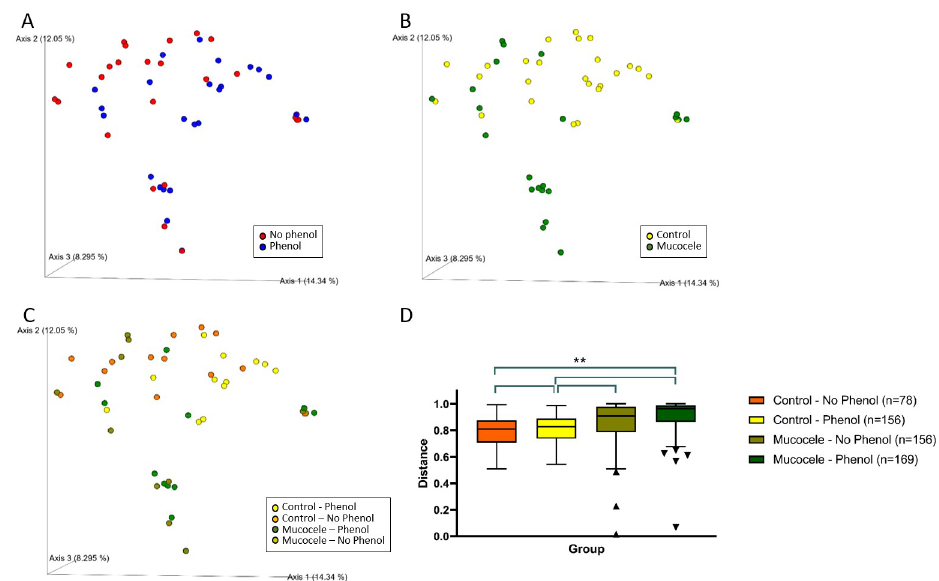
Fig 6. Beta diversity of amplicon sequence variants in gallbladder bile from 13 healthy dogs and gallbladder mucus from 13 dogs with mucocele formation each having DNA extracted using two different methods. Bray- Curtis principal coordinates analysis plots showing clustering of microbial communities based on isolation method (Panel A), disease condition (Panel B), and disease condition by isolation method (Panel C). Axis 1, 8.295%; Axis 2, 12.05%; Axis 3, 14.34%. Group significance plot comparing distances from Control—No Phenol (Panel D). Brackets represent significant differences between groups (PERMANOVA �� q < 0.01). Box and Tukey whiskers represent interquartile range (IQR) and ± 1.5 × IQR,